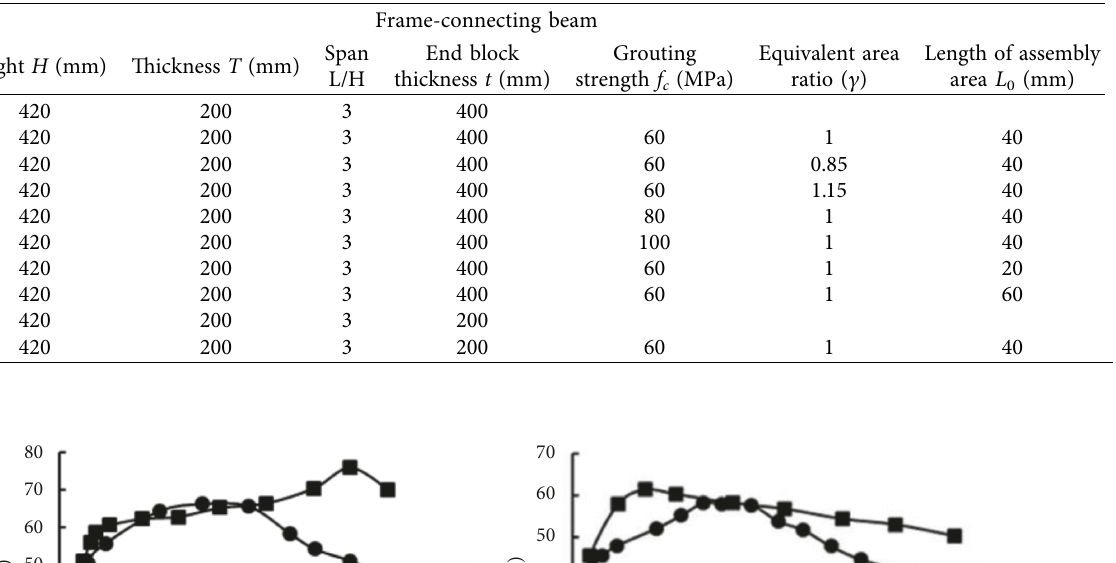
Table 3: Detailed information on finite models.